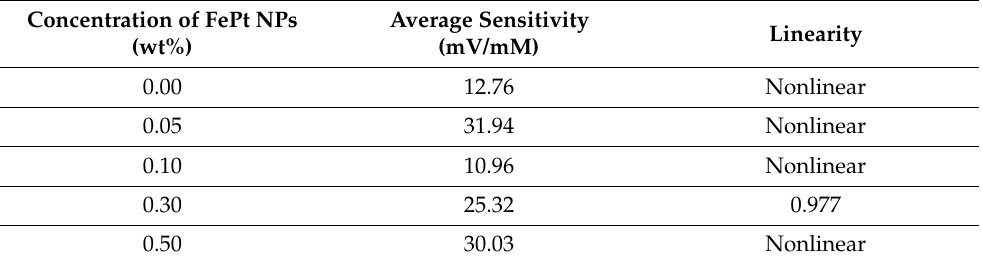
Figure 8. The average sensitivity and linearity of lactate biosensor modified by ( a ) 0.05 wt% FePt NPs, ( b ) 0.1 wt% FePt NPs, ( c ) 0.3 wt% FePt NPs, and ( d ) 0.5 wt% FePt NPs. Table 2. Comparison of the average sensitivity and linearity based on different concentrations of FePt